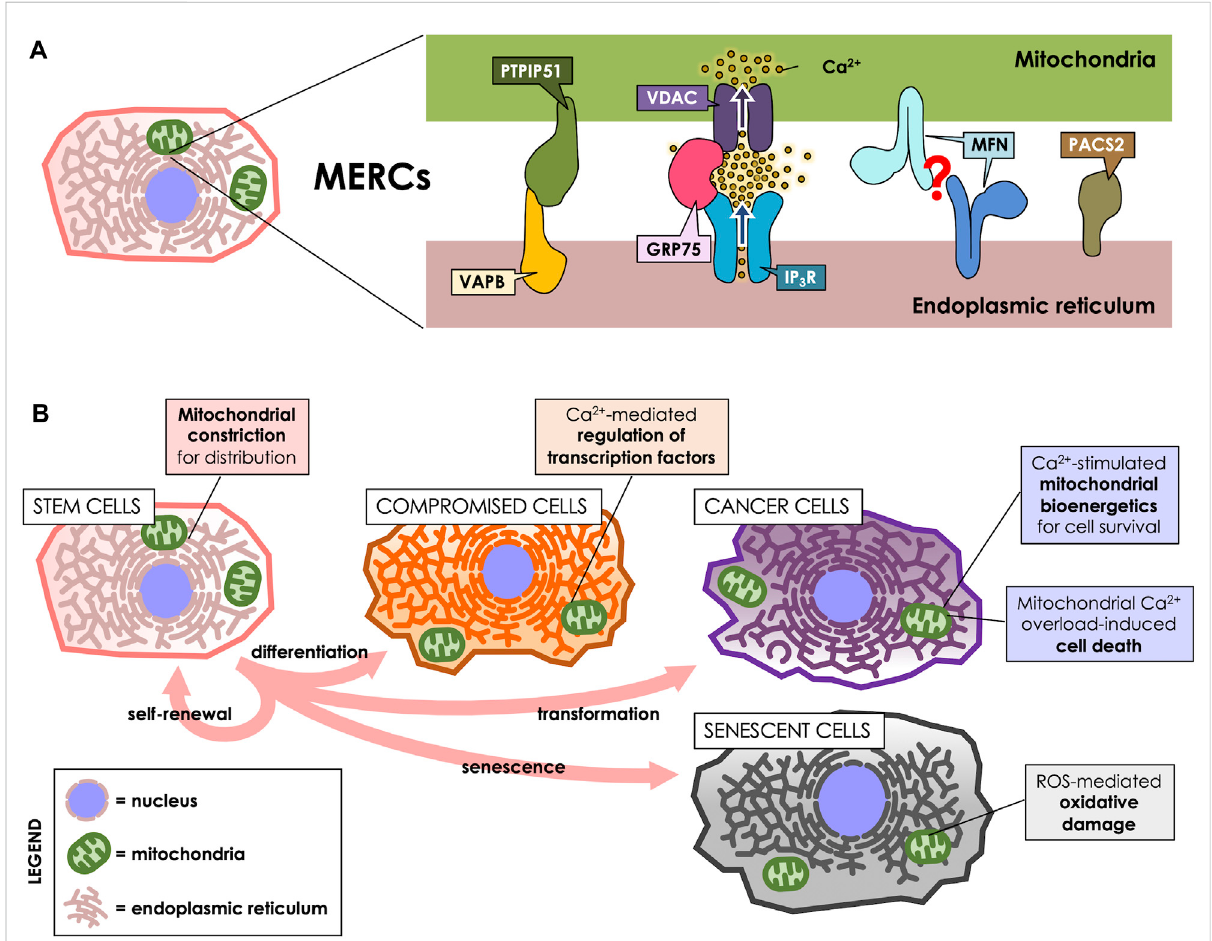
FIGURE 1 MERCs participate throughout the cell life cycle. (A) MERCs are sites of close apposition between ER and mitochondria, maintained by proteins such as Vesicle-associated membrane protein-associated protein B (VAPB) and Protein tyrosine phosphatase-interacting protein 51 (PTPIP51), which form a bridge between the surfaces of both organelles. GRP75, on the other hand, tethers the IP 3 R and VDAC Ca 2+ channels to allow for an ef fi cient Ca 2+ transfer. Mitofusins (MFNs) are present at the surface of both ER and mitochondria, purportedly forming a tether between both; however, this is a matter of controversy, as they have been proposed to also antagonize ER-mitochondria interaction. PACS-2, instead, is an ER- resident sorting protein enriched in MERCs, which governs MERCs composition. (B) MERCs have different functions according to the cell ’ s requirements. They participate in cell division, differentiation, death, survival and senescence via regulation of mitochondrial dynamics, Ca 2+ homeostasis or ROS